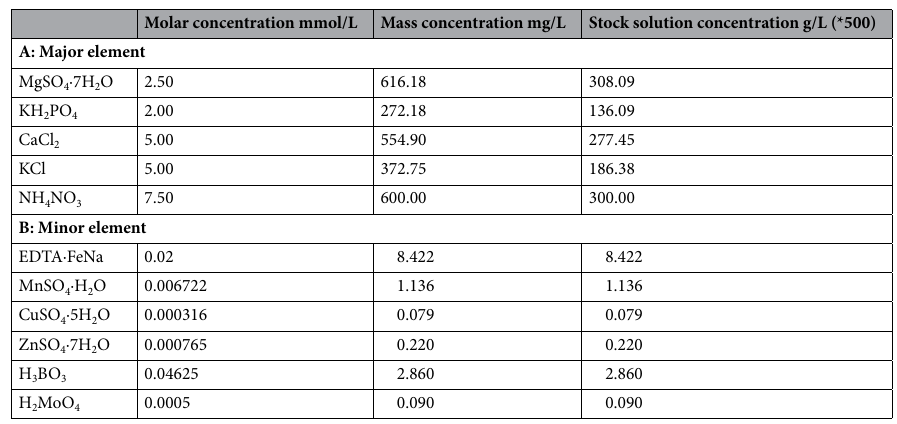
Table 1. Components of the standard Hoagland nutrient solution. A and B represent the components of the major and minor elements,